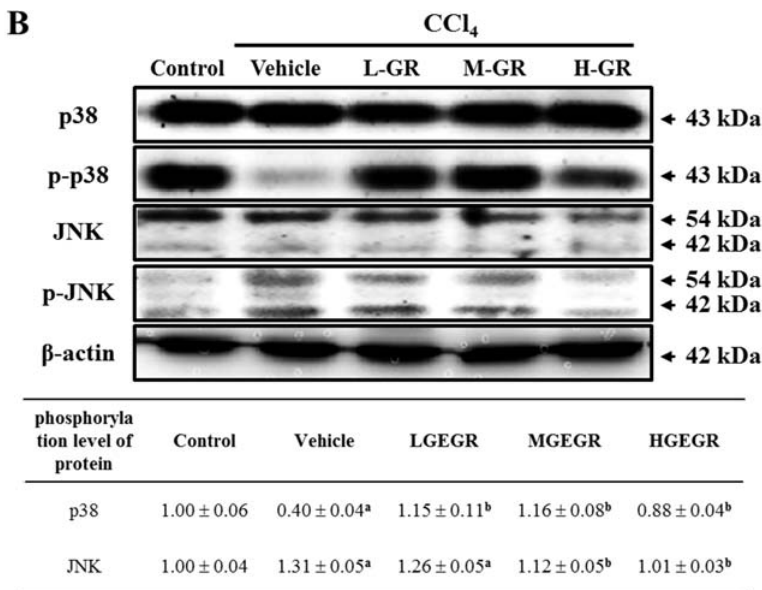
Figure 5. Analysis of inflammation related cytokines and TNF ‐α downstream signaling pathway. ( A ) Changes in the mRNA level of pro ‐ inflammatory and anti ‐ inflammatory cytokines in the no, vehicle/CCl 4 , and GEGR/CCl 4 treated group. The mRNA levels of the TNF ‐α , IL ‐ 6 and IL ‐ 10 genes were examined by RT ‐ PCR using specific primers; ( B ) Phosphorylation levels of p38 and JNK in liver tissue. To measure the expression levels of each protein, the membranes were incubated with antibodies specific for each protein, as well as β‐ actin protein from liver lysates. Three mice per group were assayed by western blotting. Values are reported as the means ± SD. a, p < 0.05 compared to the No treatment group; b, p < 0.05 compared to the vehicle/CCl 4 treated group.